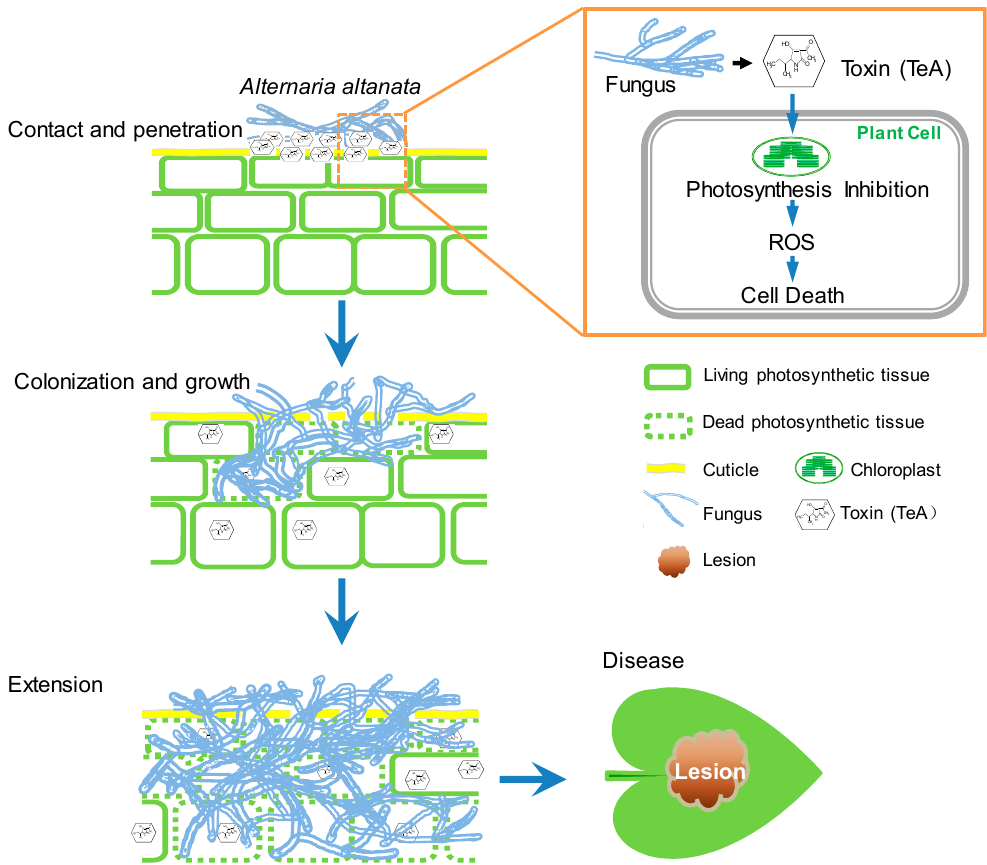
Figure 10. Model for a role of TeA in A. alternata infection. A. alternata grows subcuticularly and destroys epidermal cells by secreting mycotoxin TeA as its major virulence factor. TeA inhibits photosynthetic activity, which induces ROS burst and mesophyll cell death. Nutrition from the dead cell further promotes growth and extension of invasive hyphae in leaf tissues. Eventually, A. alternata hyphae replace large parts of leaf tissues, leading to necrotic lesion formation as a visible disease symptom. Here, hyphae are shown in light blue; photosynthetic tissue in green; plant cuticle in yellow; necrotic lesion tissue in brown; solid green lines indicate the living tissue; dashed green lines indicate the dead tissue.